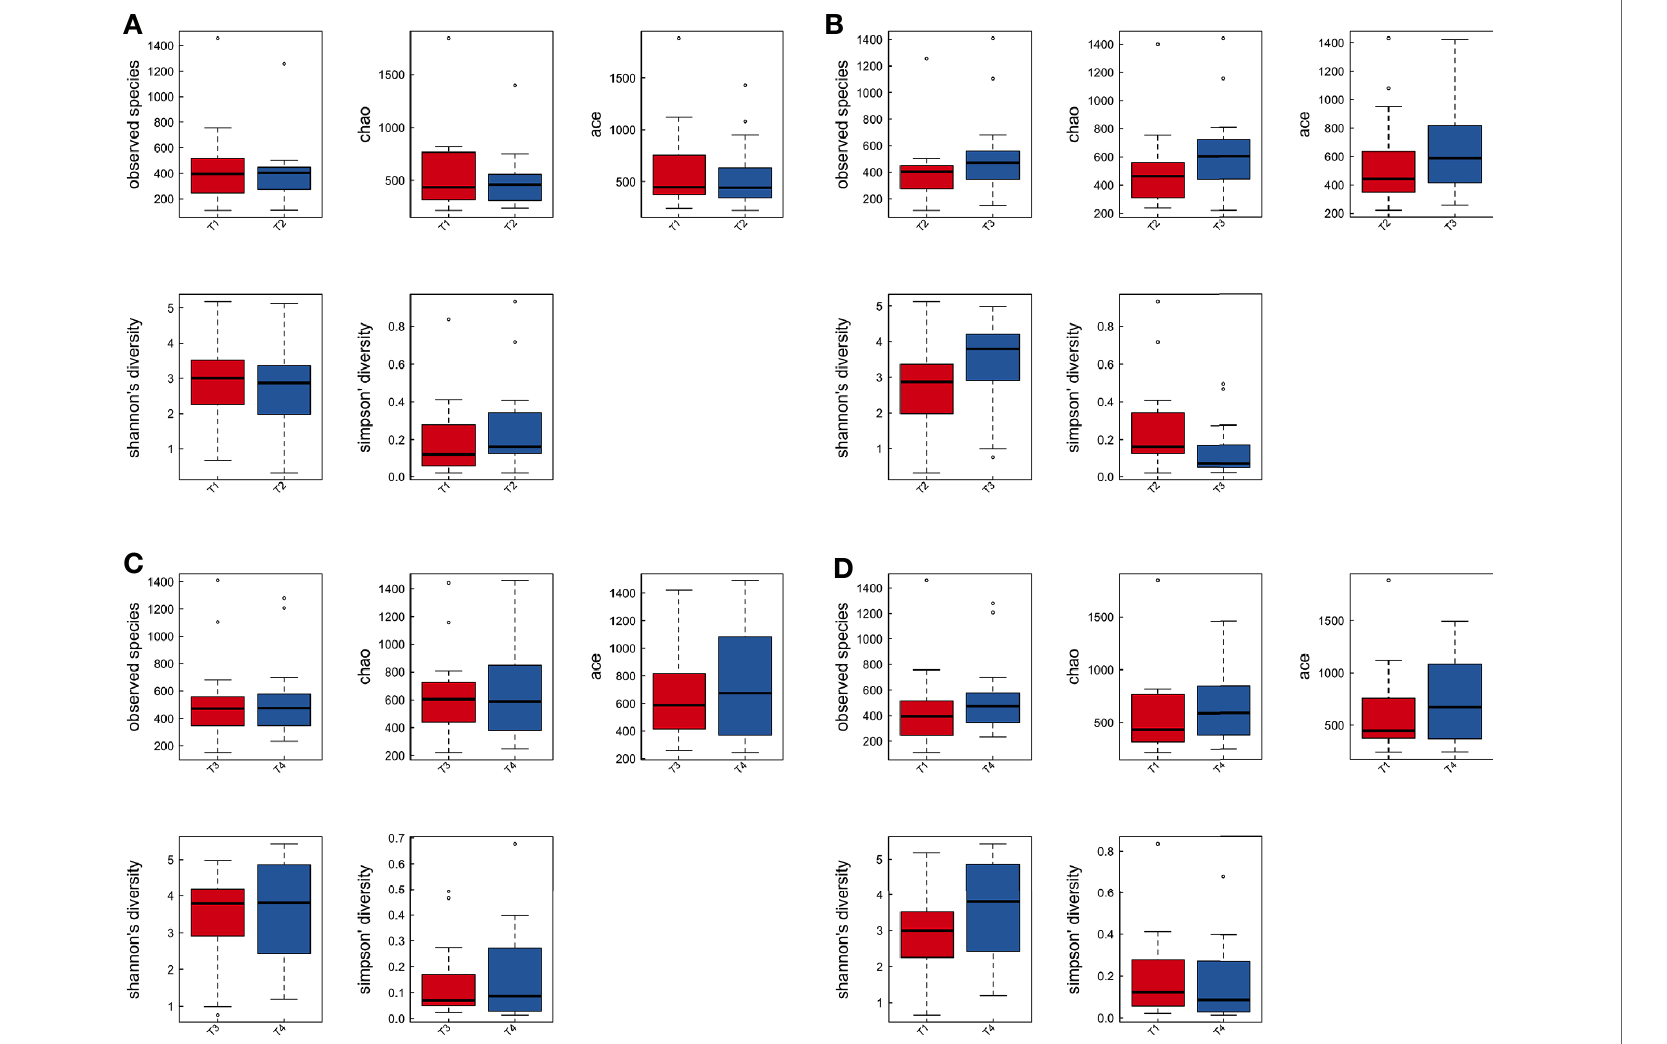
FIGURE 3 | The comparison among the four time points of patient samples by alpha diversity analysis. Boxplots of alpha diversity in T1 vs T2 (A) , T3 vs T2 (B) , T4 vs T3 (C) , and T4 vs T1 (D) using different metrics (observed OTUs, the Shannon index, and the Simpson index). T1, the fi rst time point sample; T2, the second time point sample; T3, the third time point sample; T4, the fourth time point